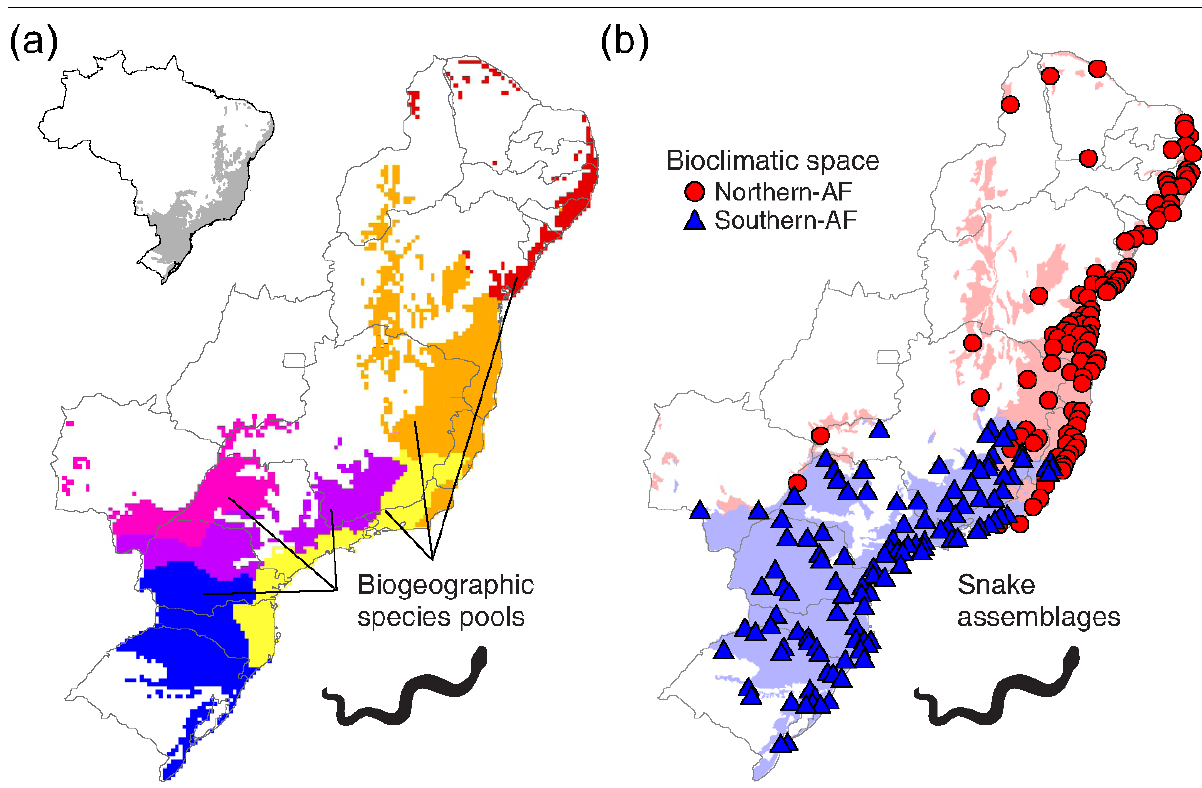
Figure 2. (a) Regionalization of Atlantic Forest (AF) snakes into six biogeographical species pools and (b) the distribu- tion of snake assemblages according to climatological regimes of northern-AF and southern-AF. Gray lines in (a) and (b) denote borders of the Brazilian states while the inset map shows the boundaries of AF in